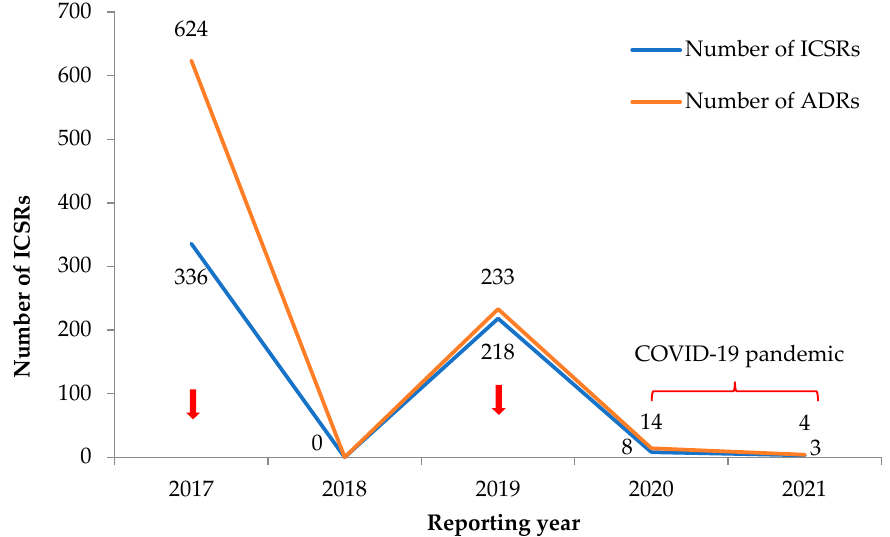
Figure 2. Yearly trend in the number of reported ICSRs with ADRs related to antimicrobials in the VigiFlow between 2017 and 2021 in Sierra Leone. Mass drug campaigns: country-wide in 2017 and in the western regions in 2019. Abbreviations: ADRs, adverse drug reactions; ICSR, individual case safety report. Note: An ICSR is reported per individual and could have multiple ADRs. Thus, the number of ADRs may be higher than the number of reported ICSRs.